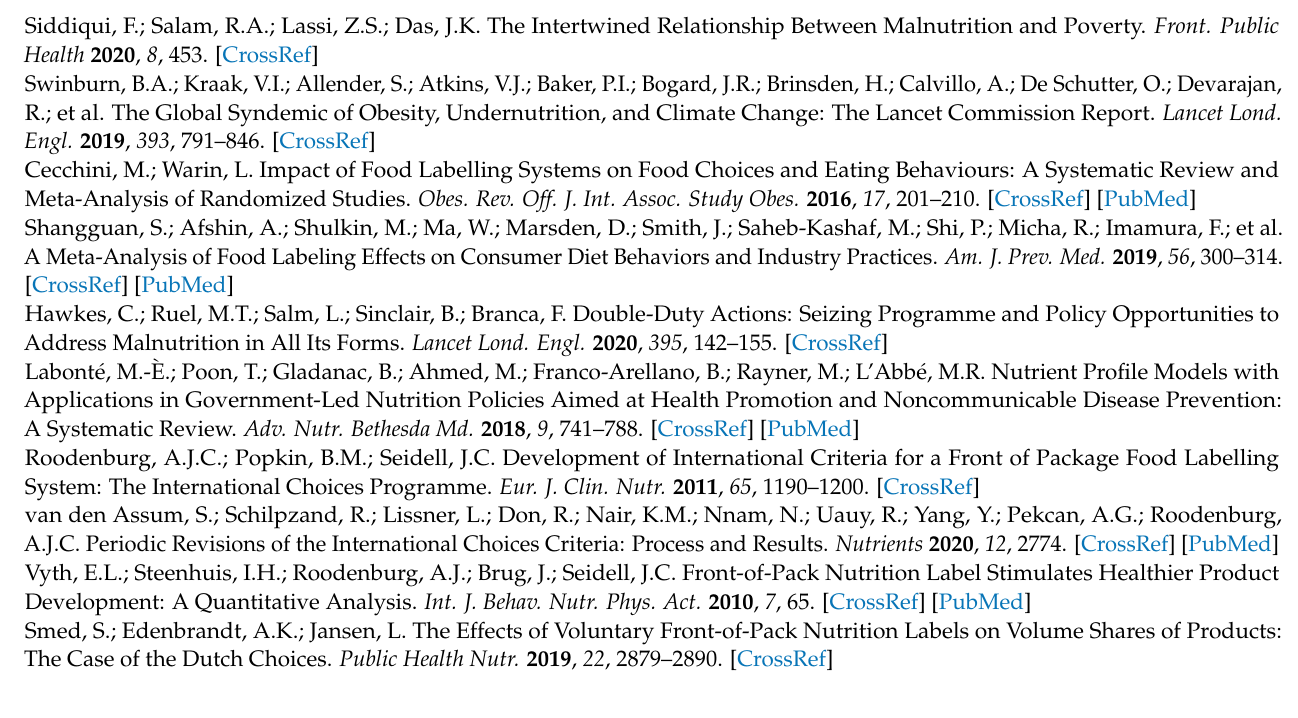
from Africa, Table S3: Indicator foods from Asia, Table S4: Indicator foods from Europe, Table S5: Intermediate thresholds for basic food groups, Table S6: Intermediate thresholds for non-basis food groups, Table S7: Summary of the responses obtained during the Choices targeted consultation, Table S8: List of changes to the intermediate thresholds following the validation by indicator foods, Table S9 Combined compliance levels C1–C4 per food group of products available in the database against thresholds T1–T4 as listed in Table 1, Document S1: stakeholder